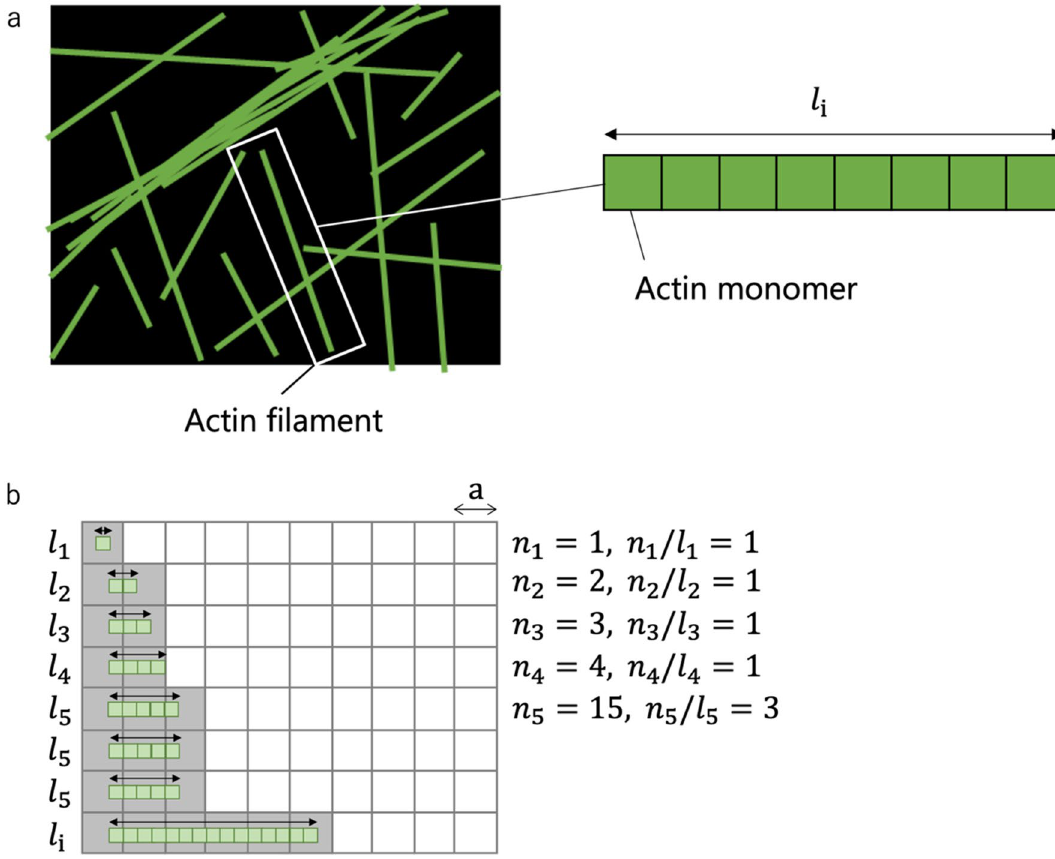
Figure 1. Schematic to explain S d . ( a ) Schematic of the cytoplasm (black) where AFs (green) assumed to be formed by one-dimensional association of actin monomers to have a length of l i are spatially distributed. ( b ) The cytoplasm is divided by compartments with a length of a . AFs (green) occupy some of the compartments (gray). The arrows in the cell show the length of AFs. An example of l i comprising of 15 actin monomers is shown. See Supporting Material for detailed